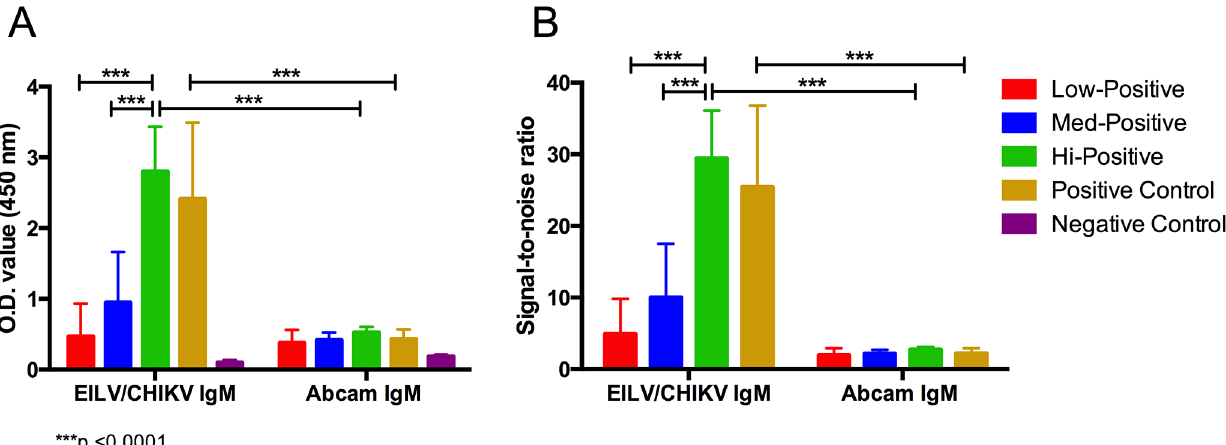
Fig 3. Comparison of EILV/CHIKV and Abcam human anti-CHIKV IgM-capture ELISA methods. (A) raw OD values or (B) signal-to-noise ratios (calculated by dividing positive sample OD values by mean negative control OD value) produced by samples of varying degrees of seropositivity were compared. Low-positive samples had PRNT 50 (cid:1) 80 (n = 4), medium-positive samples had PRNT 50 160 – 320 (n = 4), and high-positive samples had PRNT 50 > 640 (n = 24). Mean and standard deviations are reported. A 2-way ANOVA with Tukey ’ s test was used to compare absorbance values and signal-to-noise ratios within each ELISA method. 2-way ANOVA with Bonferroni ’ s test was used to compare absorbance values and signal-to-noise ratios between each ELISA